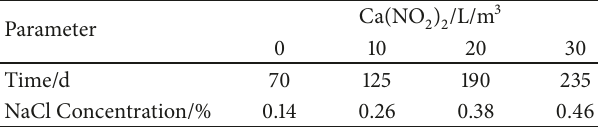
Table 1: Initial corrosion in relation to the NaCl